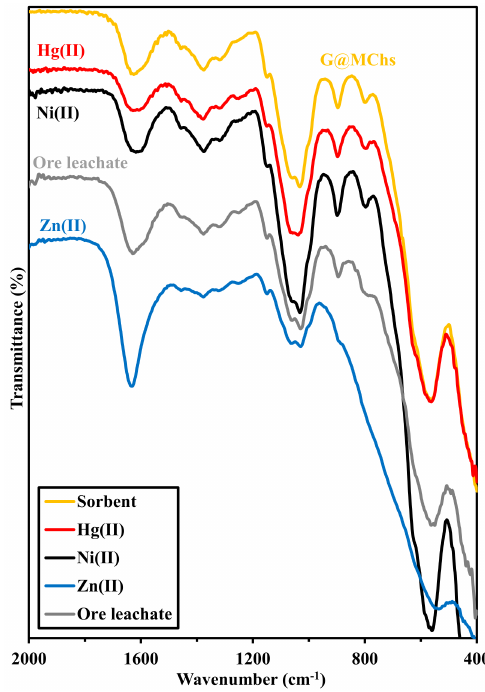
Figure 3. FTIR spectra of G@MChs sorbent before and after Ni(II), Zn(II), Hg(II) and after treatment of ore leachate, in the wavenumber range: 2000–400 cm − 1